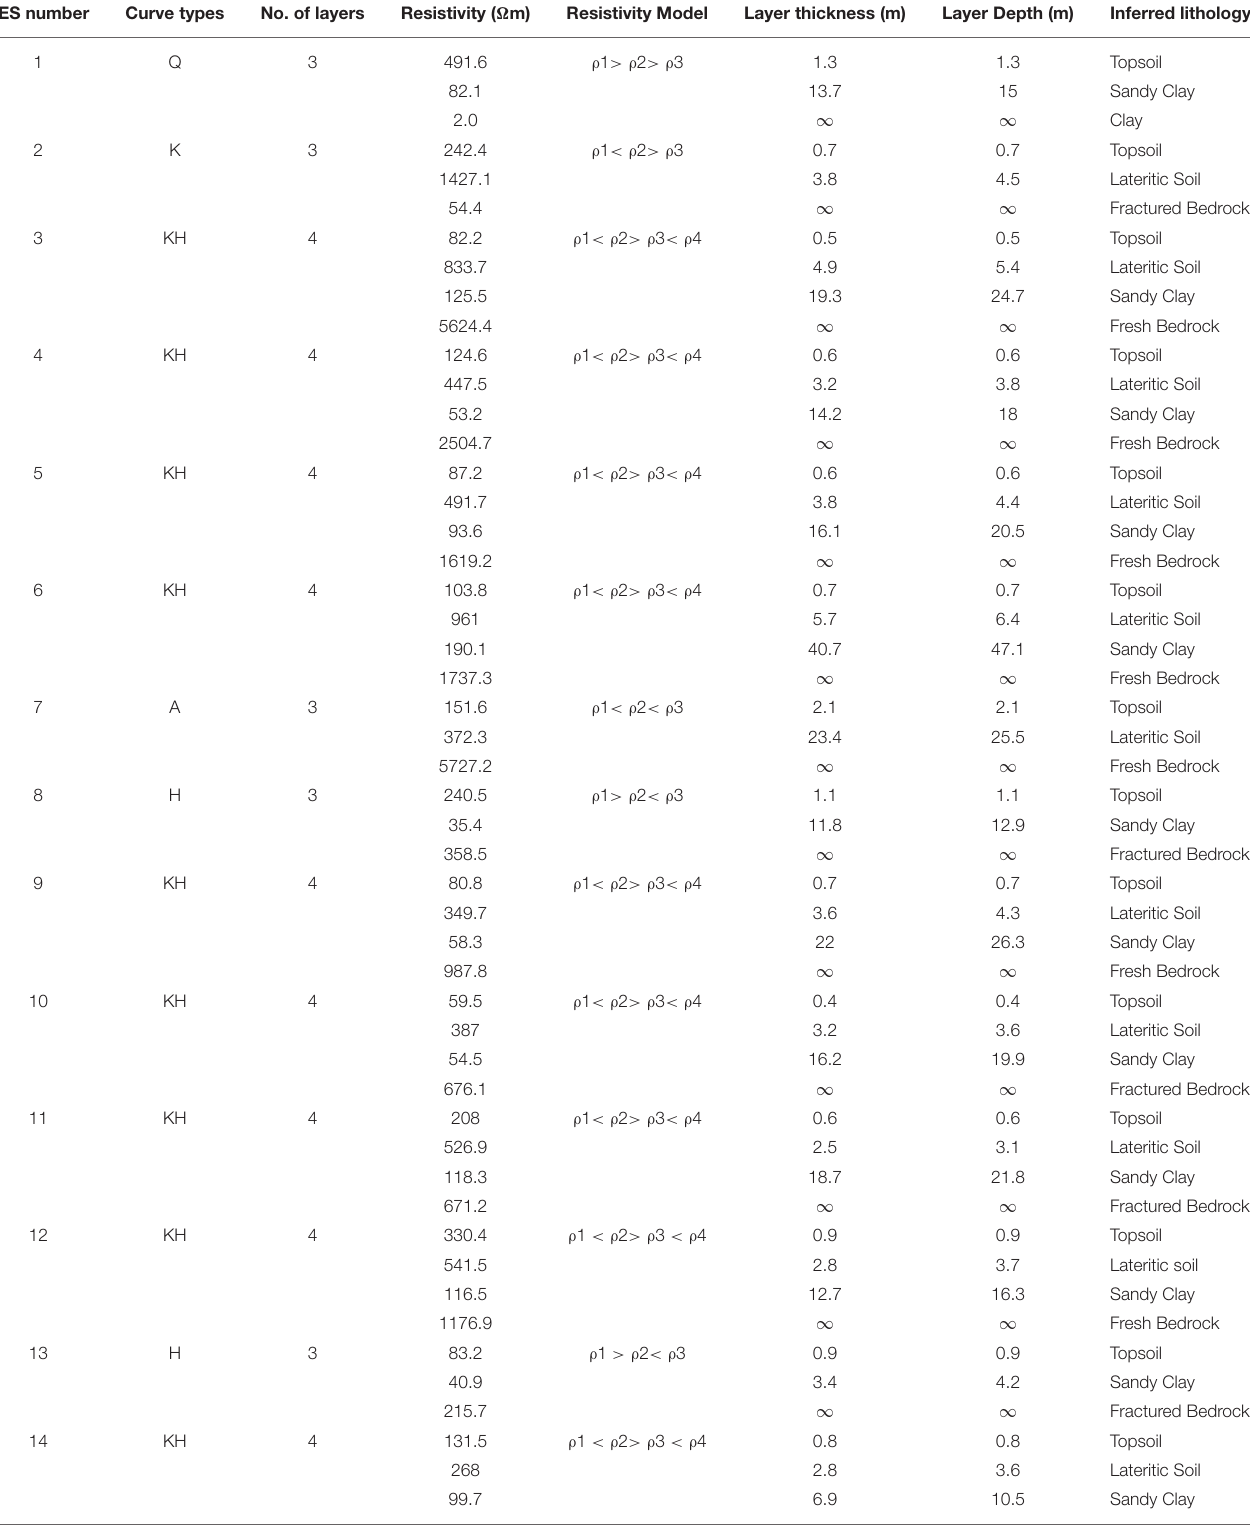
TABLE 1 | Geoelectrical sequence of Aaba community. VES